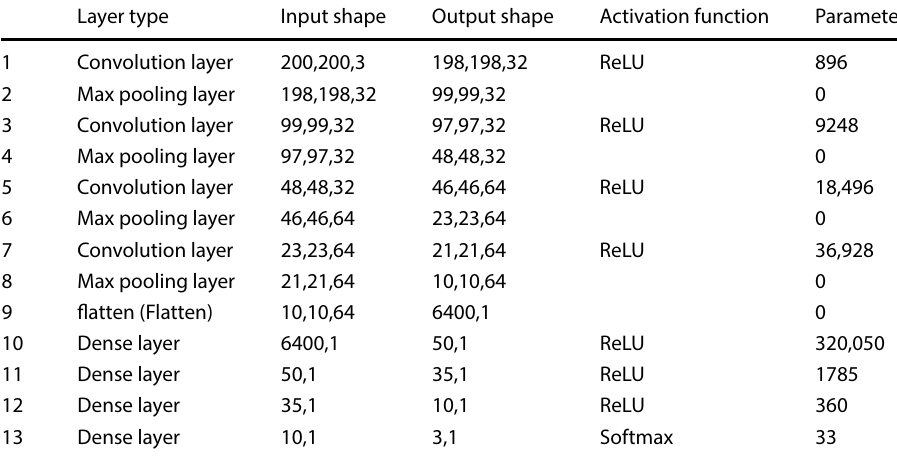
Table 1 CNN architecture for wear type classification